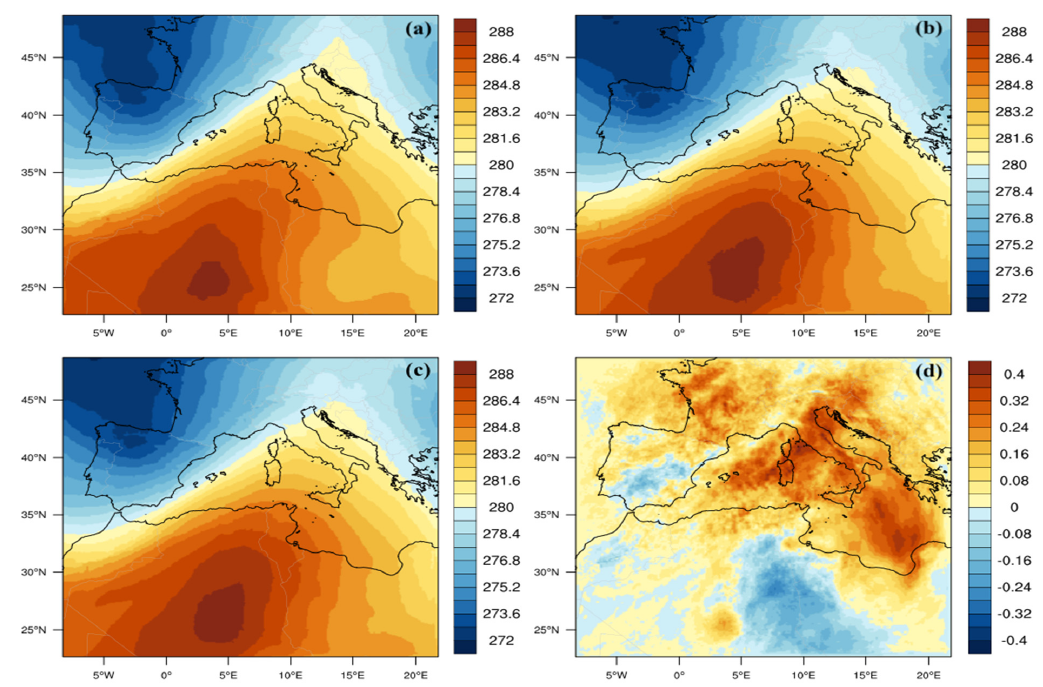
Figure A3. Averaged (17–24 June) temperature at 900 hPa by ( a ) ERA5; ( b ) CTL; ( c ) FULL; ( d ) FULL − CTL. Units are K.